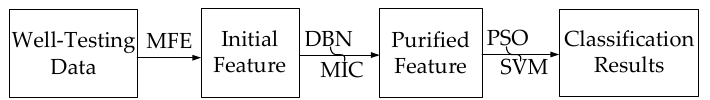
Figure 1. Multi-feature extraction method and deep mutual information classifiers (MFE-DMIC) algorithm framework. MIC: maximum information coefficient.